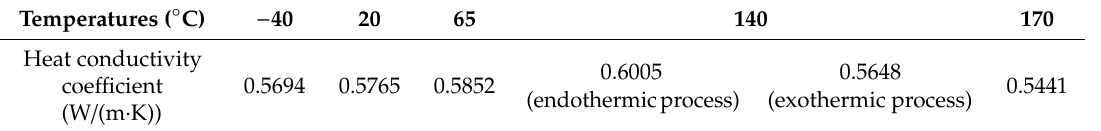
Table 1. Heat conductivity coefficients of the PCTIA at different temperatures. Temperatures ( ◦